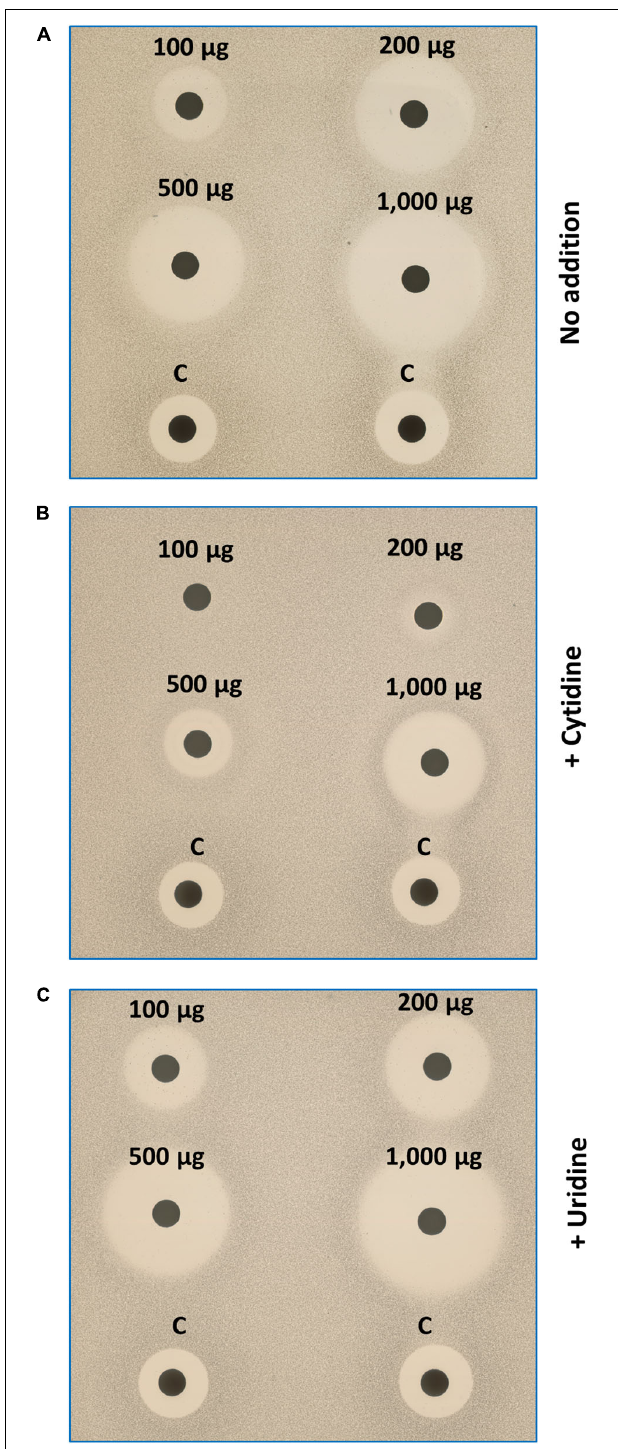
FIGURE 5 | Effects of exogenous cytidine and uridine on growth of IQC treated cells. The disc diffusion plates were seeded with the (cid:49) 4 cells. Discs were impregnated with different quantities of IQC or the control compound (Citrox). (A) Medium (NA/Mg 2 + ) only; (B) Medium supplemented with cytidine (2.5 mM); (C) Medium with uridine supplement. The addition of cytidine (but not uridine), can compensate the CTPS inhibition by